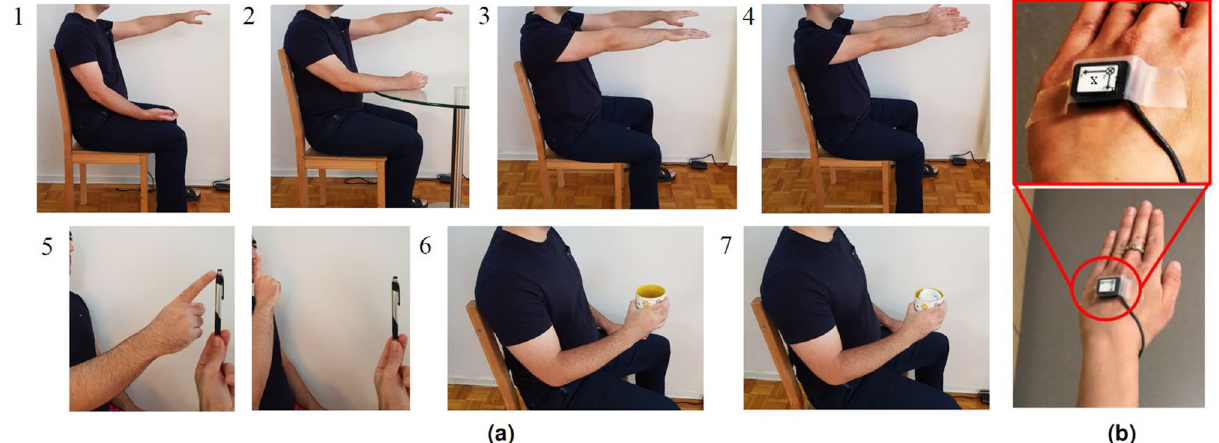
Figure 1. ( a ) Illustration of the 7 scripted tasks performed by PD and ET patients for each tremor assessment. (1) Rest-1; (2) Rest-2; (3) Posture-1; (4) Posture-2; (5) action tremor (repetitive finger to nose motion); (6) Load-1 (empty cup); (7) Load-2 (1-lb weight in the cup). ( b ) Placement of the 3-axis accelerometer sensor on the dorsum of hand. Please note that this figure is reproduced from the Figure 1 of the work by Shahtalebi et al. 25